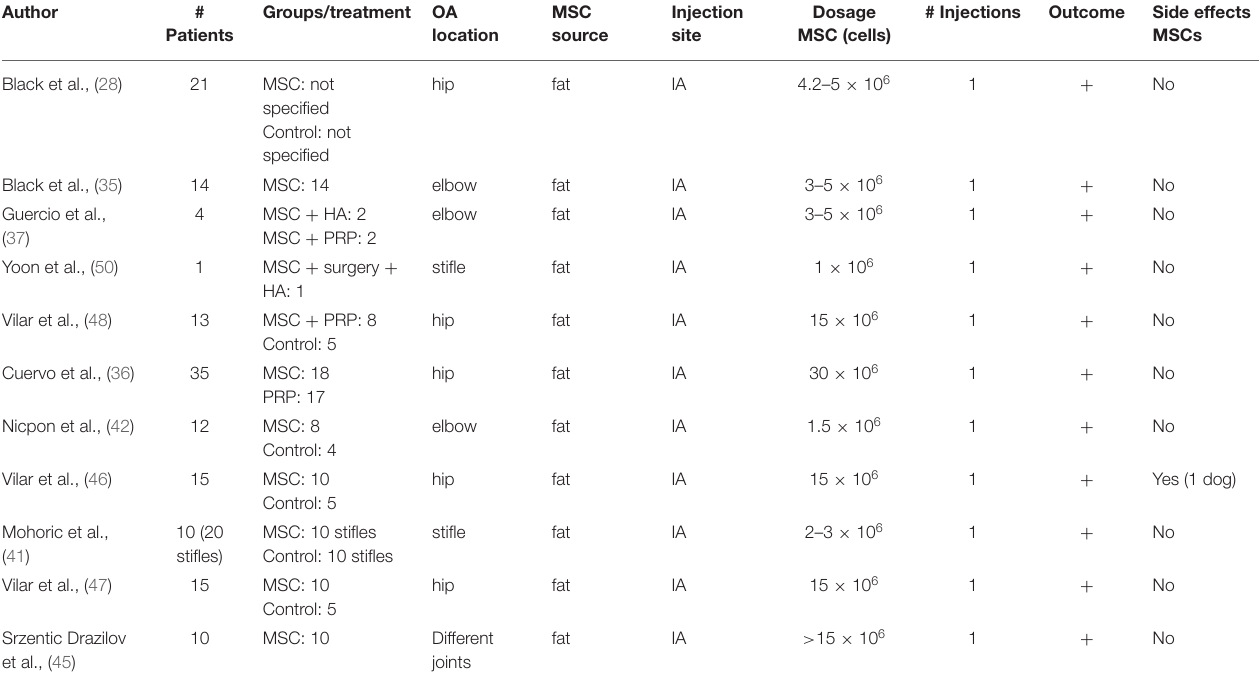
TABLE 1 | Chronologic presentation of studies on naturally occurring OA applying autologous